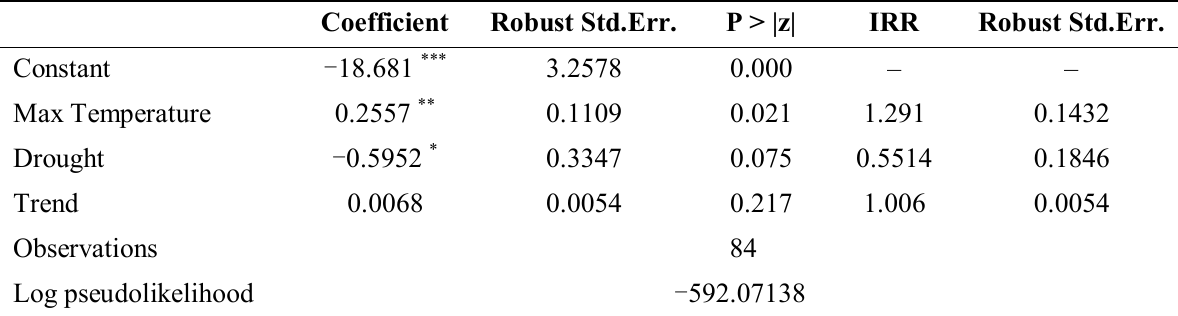
Table A1. Negative binomial model—Monthly data: Cholera cases.